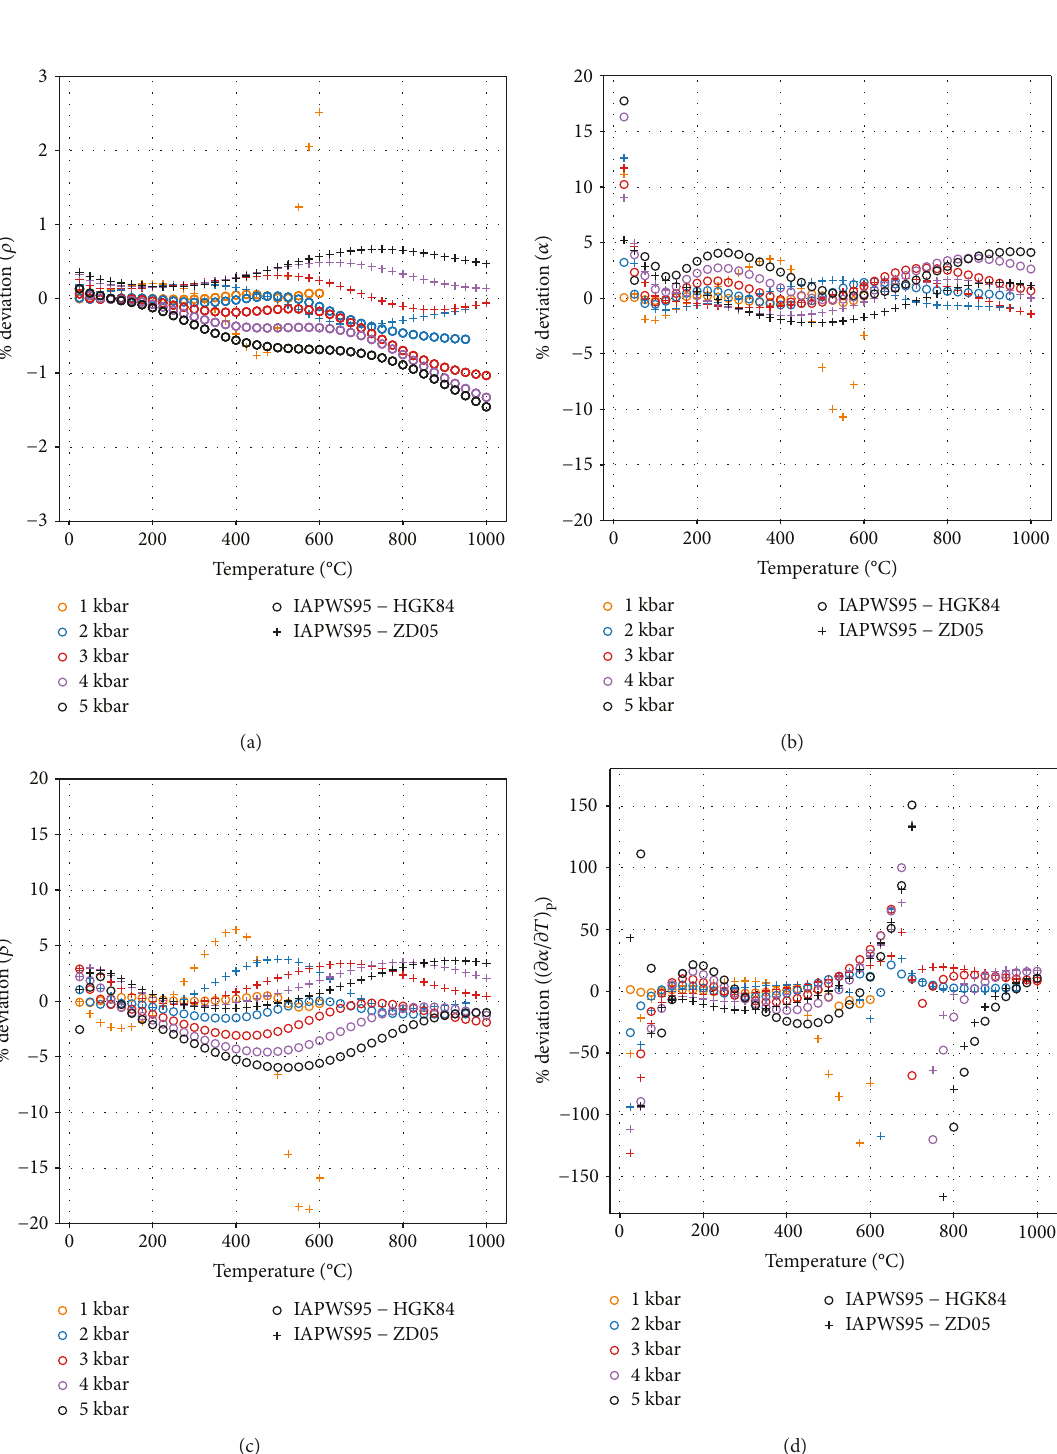
(water density), (b) α (isobaric expansivity), (c) β H 2 O H 2 O H 2 O (isobaric temperature derivative of the isobaric P